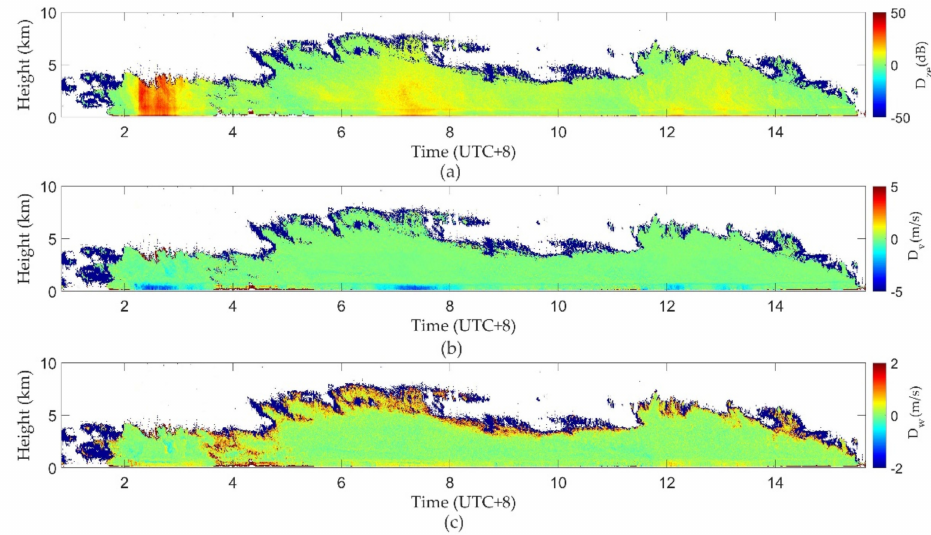
Figure 6. Difference in the ( a ) Z e , ( b ) V and ( c ) W between the Ka- and W-band radar on 11 August 2019.